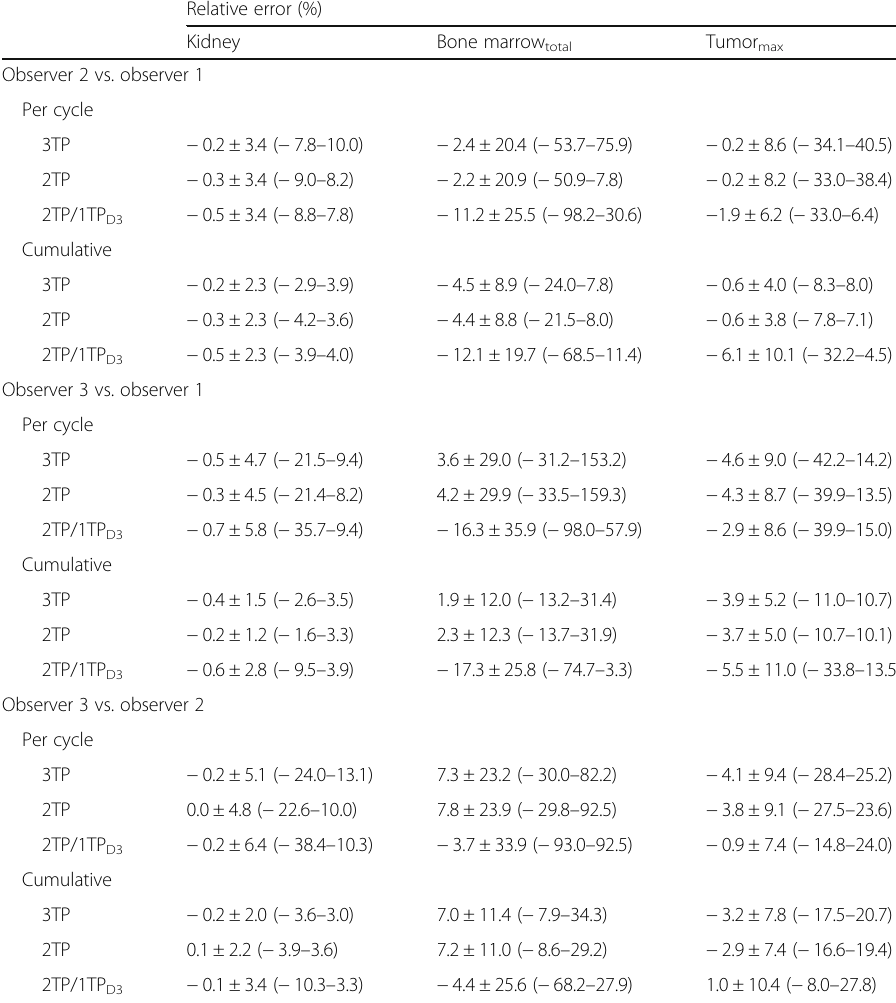
Table 6 Inter-observer variability of dosimetry estimates in 60 induction cycles received by 15 patients Relative error (%) Kidney Bone marrow total Tumor max Observer 2 vs. observer